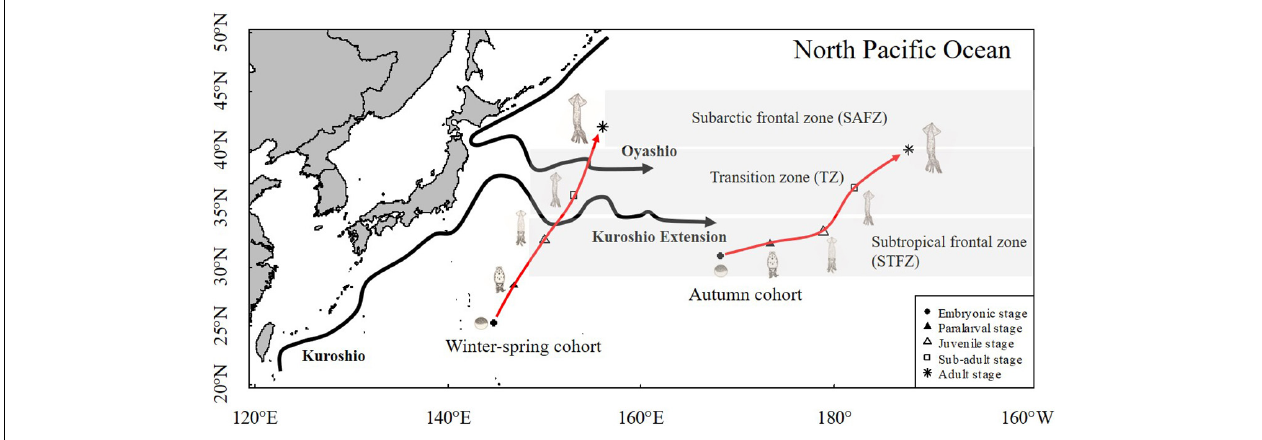
FIGURE 8 | Scheme of reconstructed migration route for autumn cohort and winter-spring cohort of Ommastrephes bartramii based on longitude and latitude center of gravity.